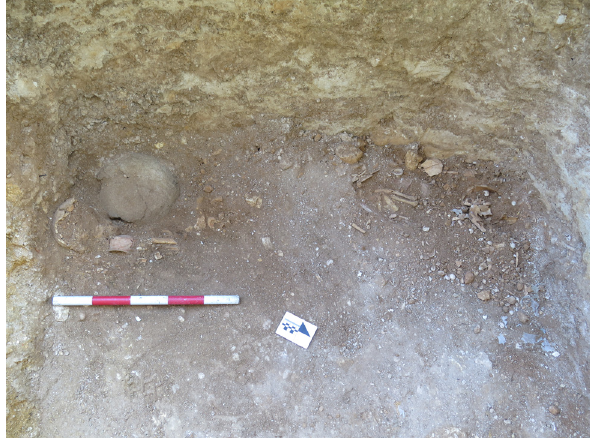
Figure 8: Uncovering of skull 1 ( far left ) ; the infant burial 3 ( West of skull 1 )